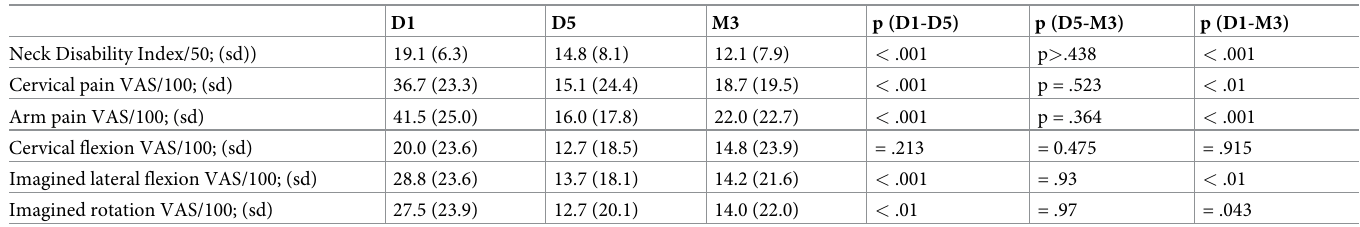
Table 1. Results and comparison of disability and pain evolution between D1, D5 and M3.